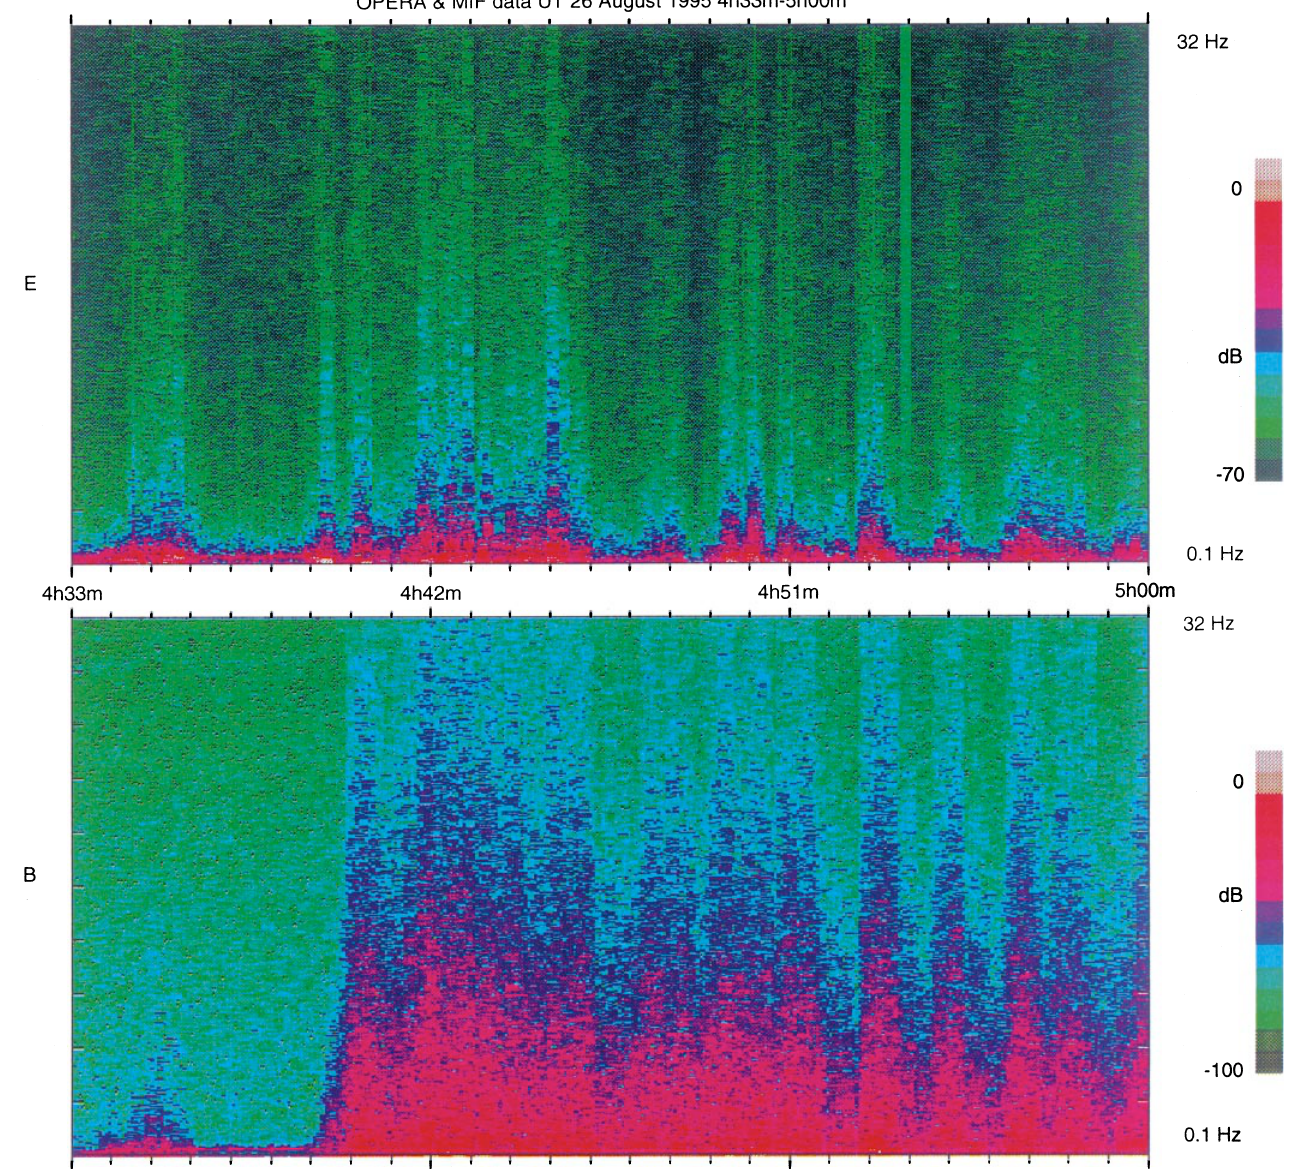
Fig. 7. High-latitude magnetopause crossing 26 August 1995. Spectrograms of the E x ( top ) and B z ( bottom ) waveform signals. Frequency range is